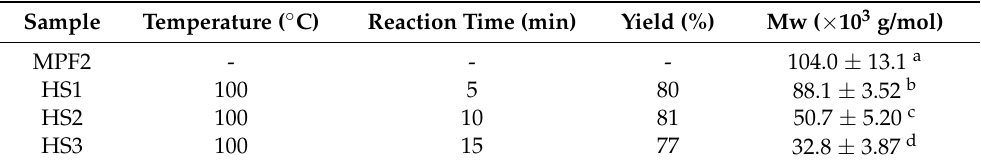
Table 3. Preparation conditions for acid hydrolysis (HS1, HS2, and HS3) and molecular weight of MPF2 and its derivatives from A. hemibapha